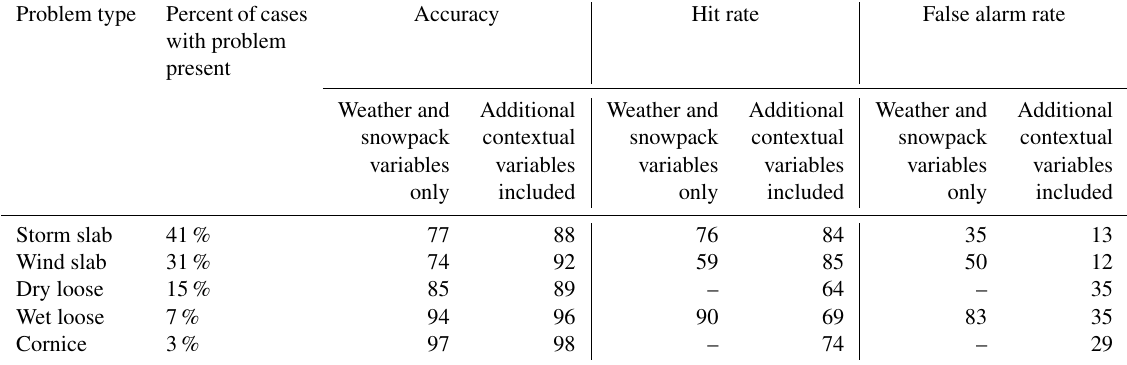
Table 6. Contingency table statistics when classifying the presence of surface avalanche problem types with decision tree